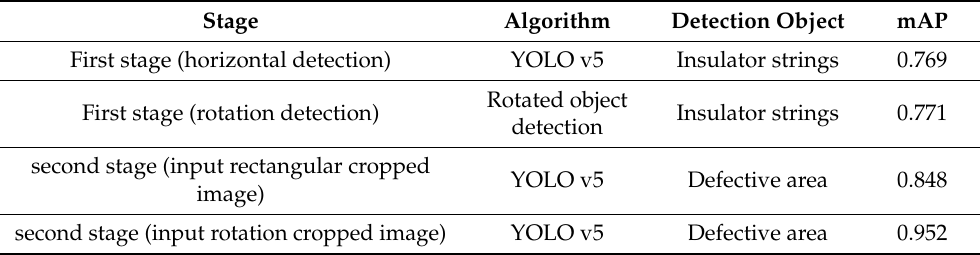
Table 2. Comparison of two-stage cascading architecture insulator defect detection